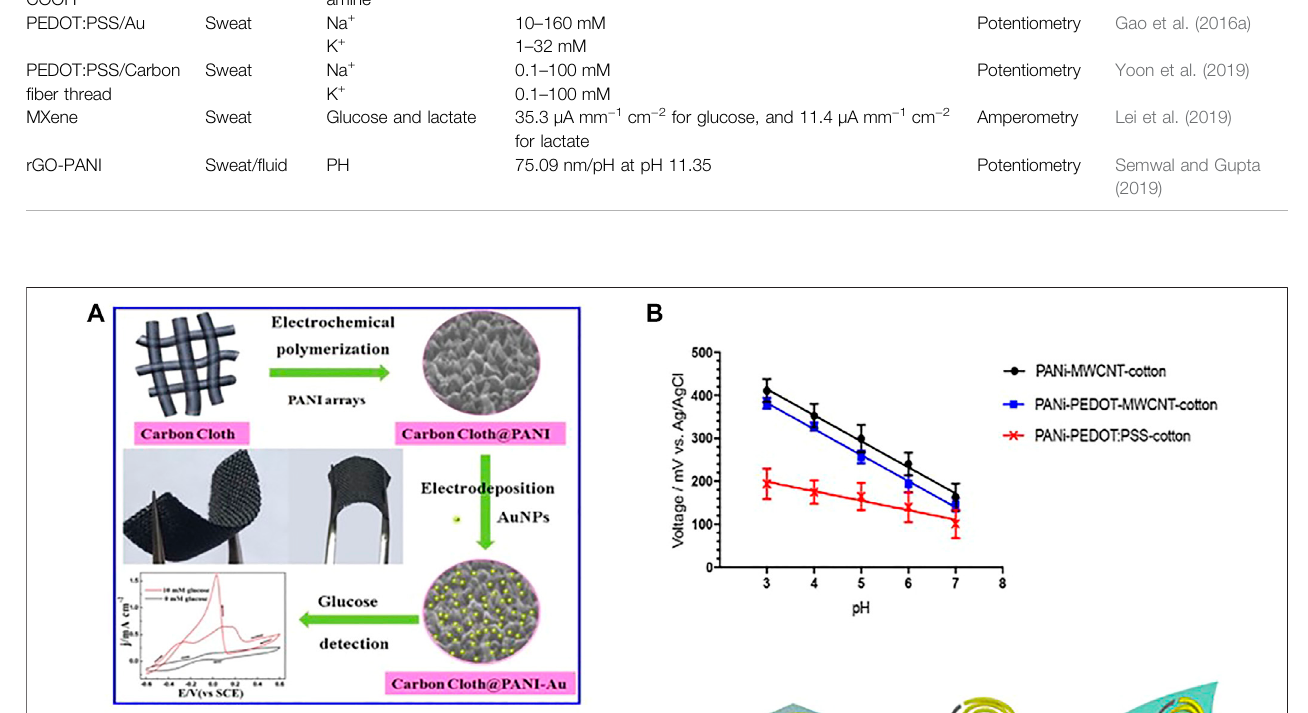
Frontiers in Bioengineering and Biotechnology |